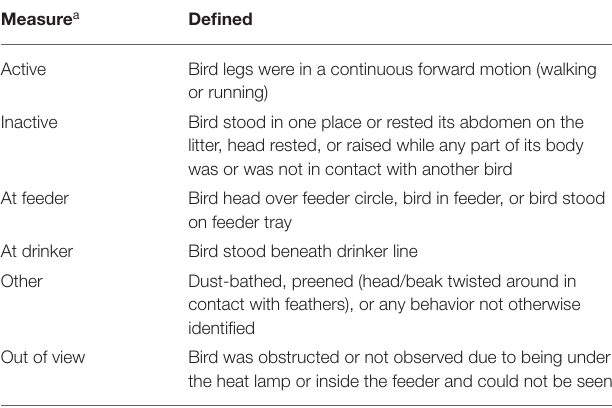
TABLE 1 | Broiler home pen behavior ethogram; focal bird behavior was measured continuously during 4-min laser periods, 4 times daily at 05:30, 11:30, 17:30, and 23:30 for d0–9, 16, 23, 30, and